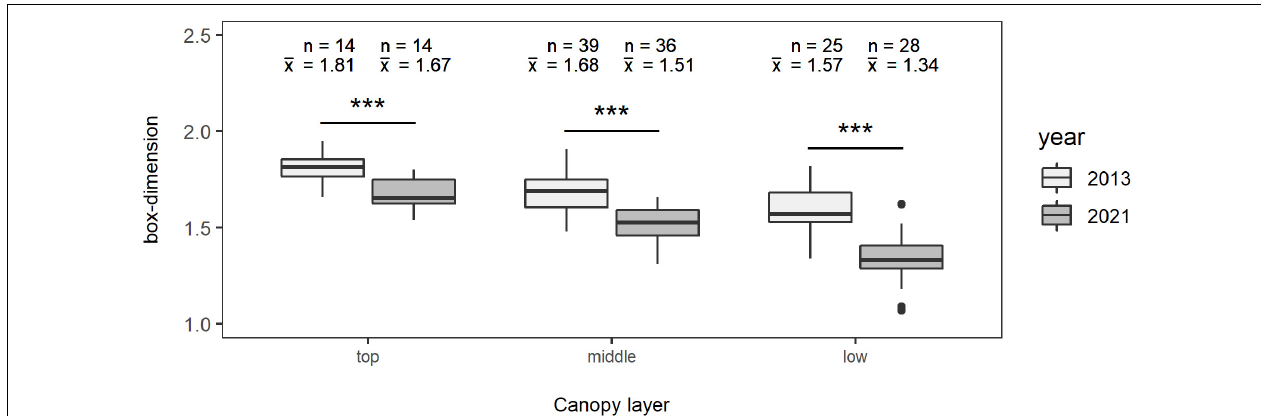
FIGURE 3 | Mean box-dimension of the trees in winter 2013 (light gray) and winter 2021 (gray) in the different canopy layers “top” (left), “middle” (middle), and “low” (right) for a total of 78 observations. The bold black lines mark the median of the boxes in the box-and-whisker charts, “n” represents the number of observations, and “¯x” represents the arithmetic mean value of the respective layer in the specific year. Significant differences between the years of each layer are shown: *** p < 0.001.